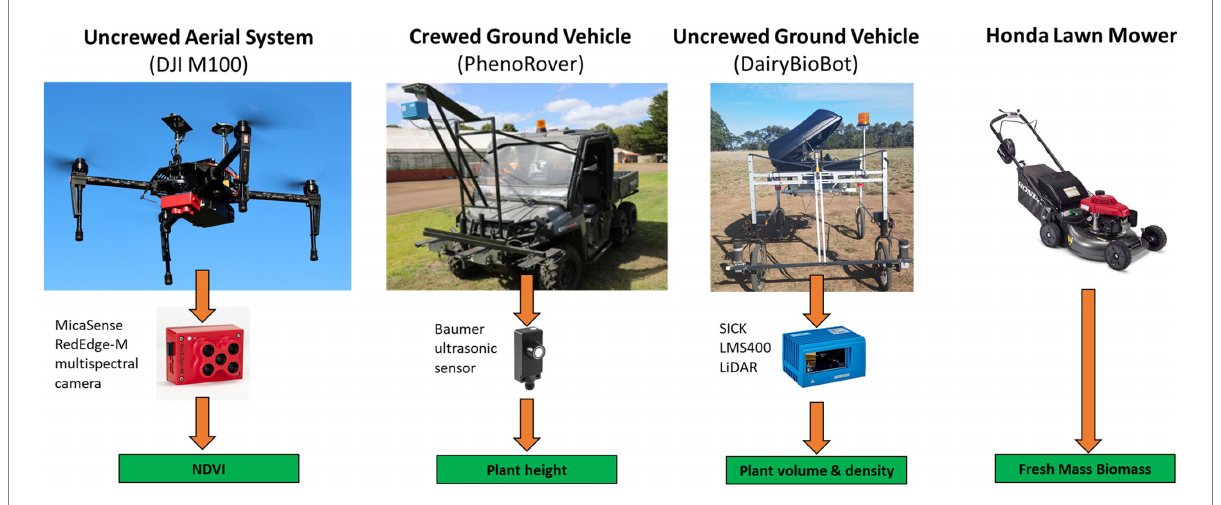
FIGURE 1 Aerial and ground-based high-throughput phenotyping platforms used in this study to estimate an empirical relationship with harvested fresh biomass from a manual lawn